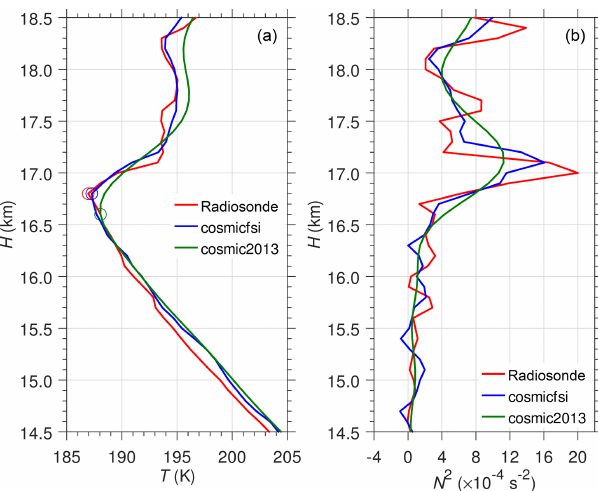
Figure 2. Mean N 2 profiles from radiosonde (red), cosmicfsi (blue), and cosmic2013 (green) data during CINDY-DYNAMO 2011 (a) . Zonal mean N 2 profile in the 10 ◦ S–10 ◦ N latitude range from 10 years of cosmicfsi data (b) . All heights are relative to the